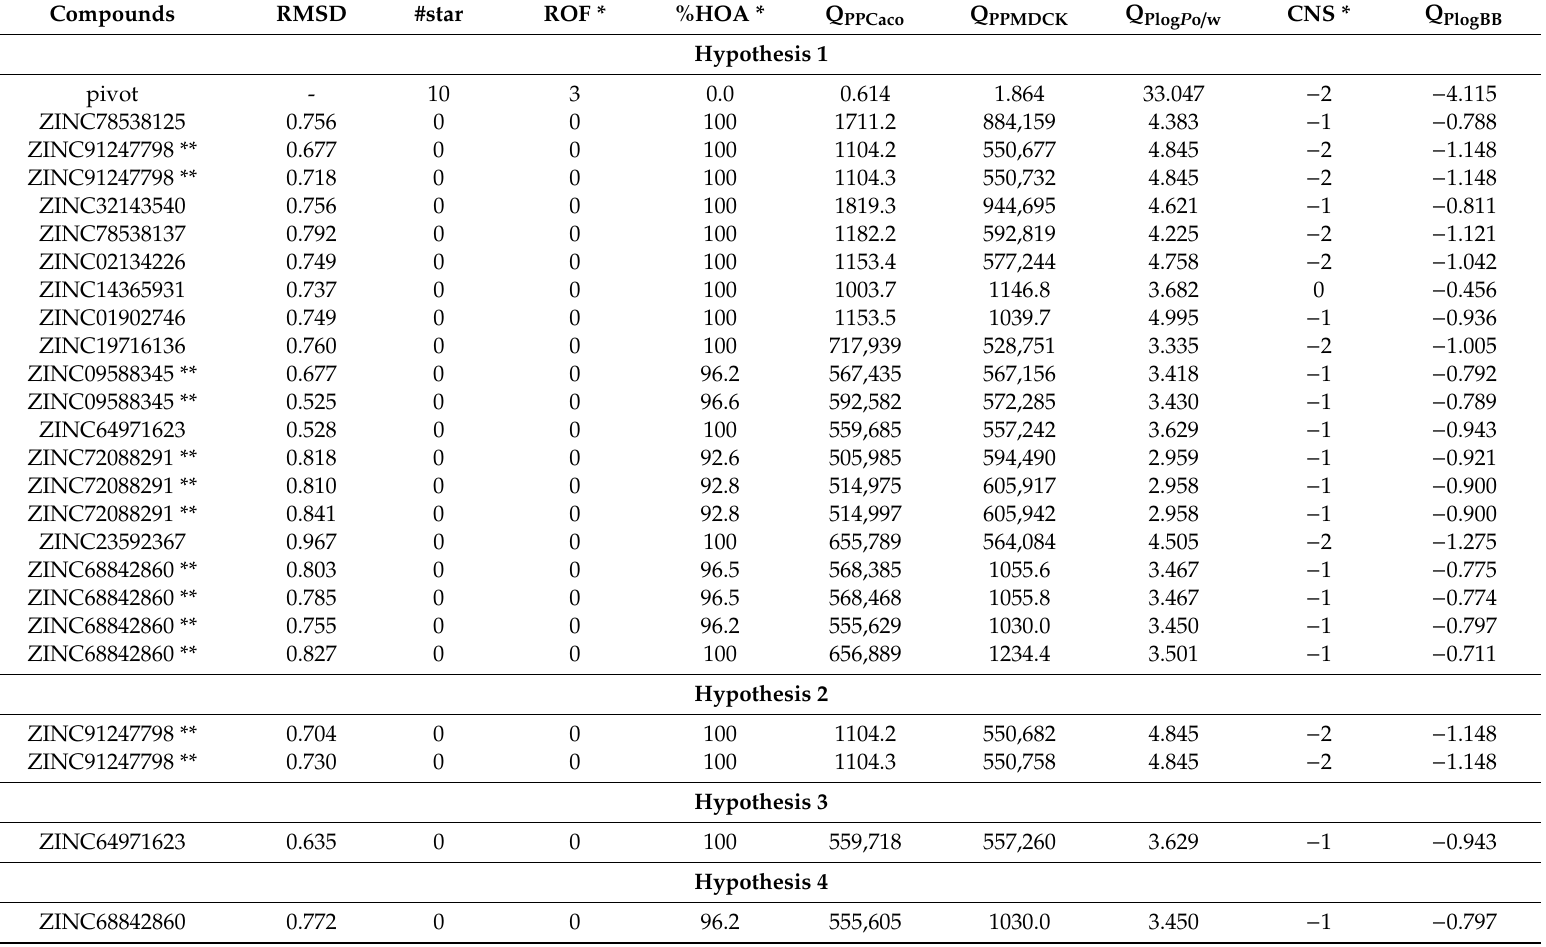
Table 5. Pharmacokinetic prediction values for the four hypotheses (QikProp